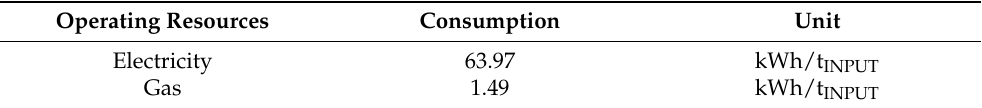
Table 5. Resource consumption of the